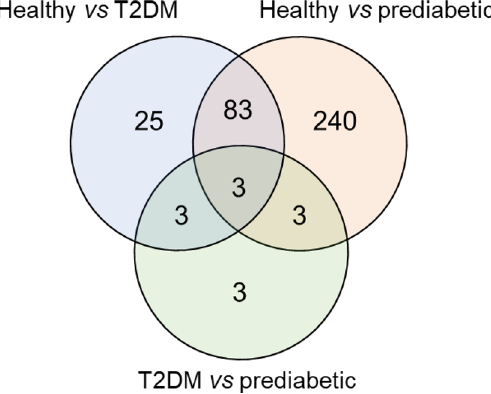
Figure 9. Venn diagram showing number and overlap of metabolites with significant differences in the response to